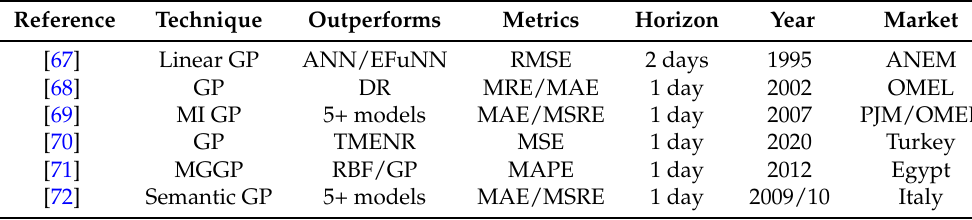
Table 3. Summary on genetic programming (GP) for electricity